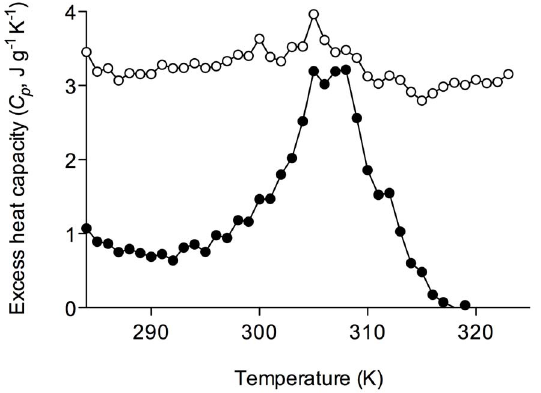
N ) and PNIPA-20AA(5) ( # )